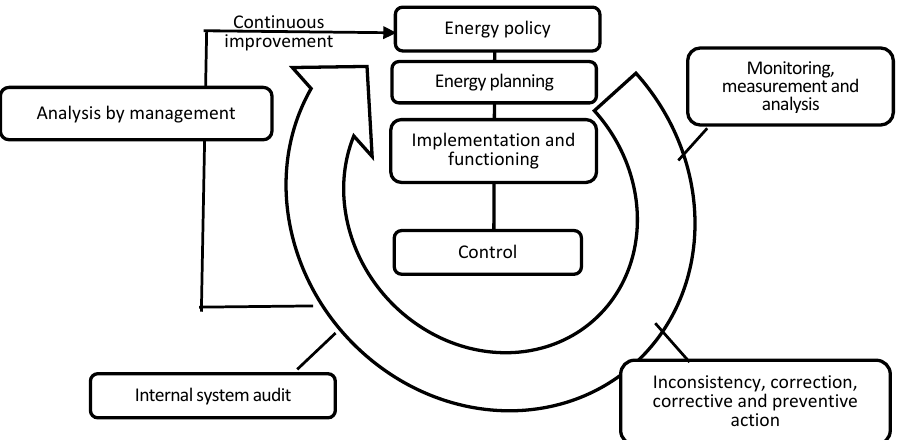
Fig. 1: Use of ISO 50001: 2011 standard for building a University energy management system